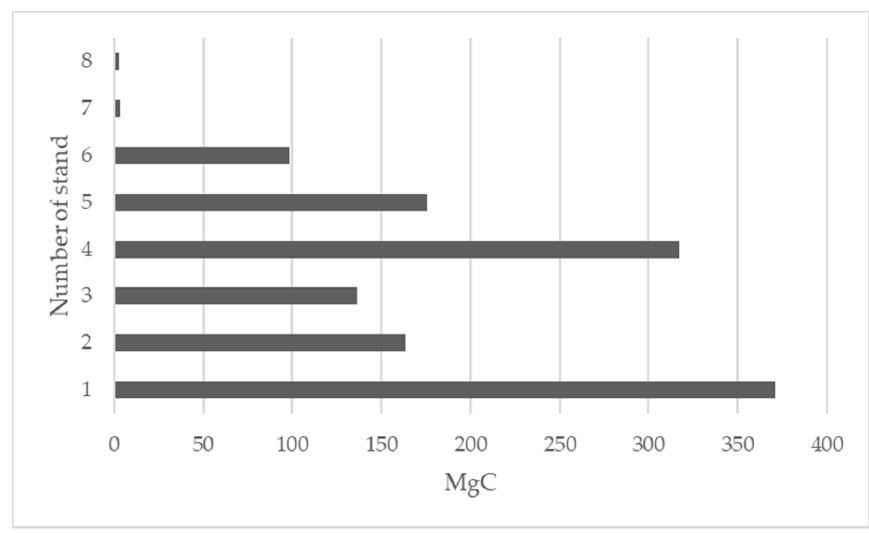
Figure 4. Annual carbon capture above-ground per stand.